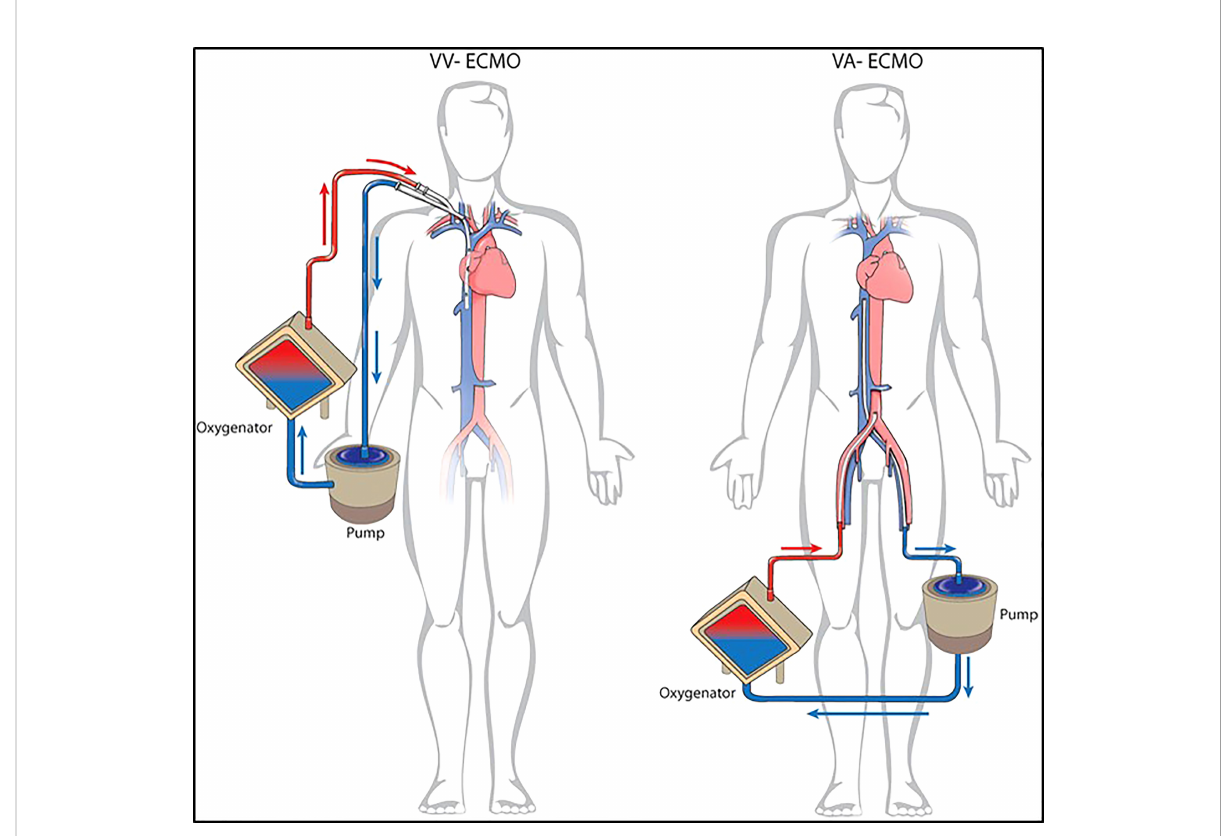
FIGURE 1 Different con fi guration for ECLS. V-V ECMO and V-A